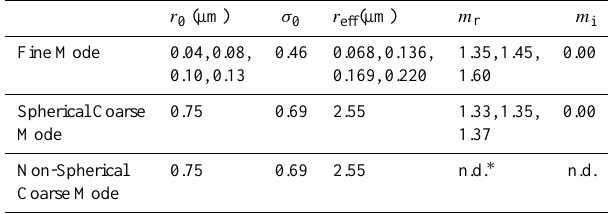
Table A1. Size distribution parameters of the aerosol models over ocean. m r and m i are the real and imaginary parts of the refractive index. For the non-spherical mode, the phase matrix is directly ob- tained from Volten et al. (2001); the size parameters r 0 and σ 0 are assumed equal to the values of the spherical coarse mode; no val- ues are assigned for the refractive index. The non-spherical fraction within the coarse mode is set to 5 discrete values: 0.00, 0.25, 0.50, 0.75 and 1.00.